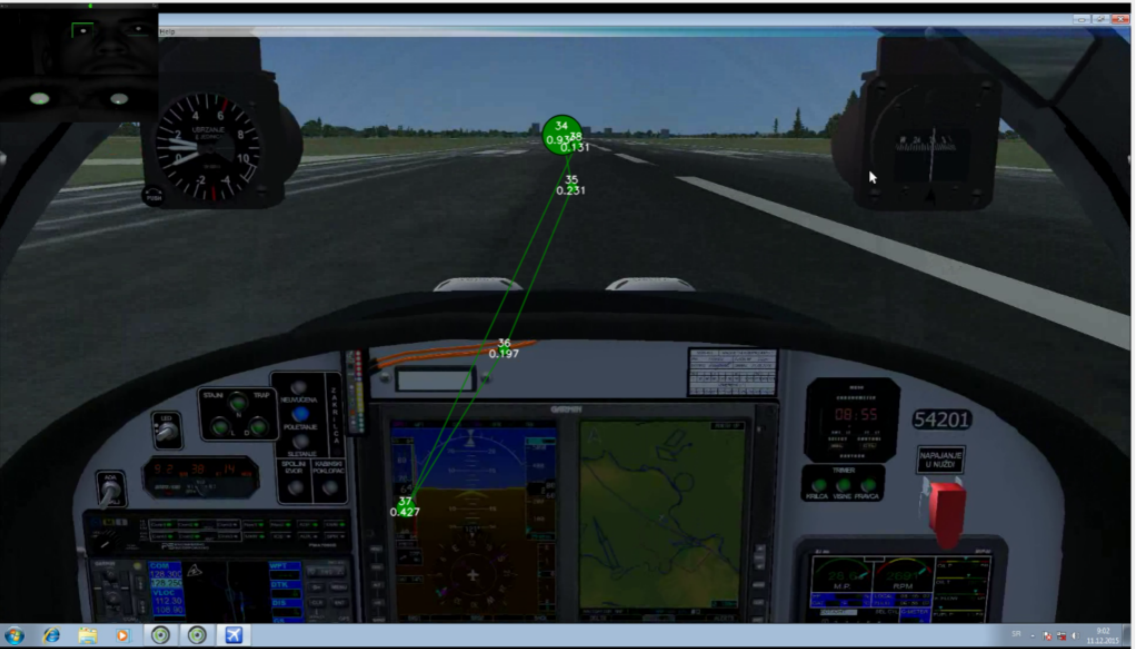
Figure 10. Recording of participant P5 Take off phase. Gaze plot of 3 seconds duration. Fixation (Green circles) of evi- dently smaller radius and thus shorter duration. Saccades (transitions) from AOI ‘AST’ to AOI ‘OC’ present.